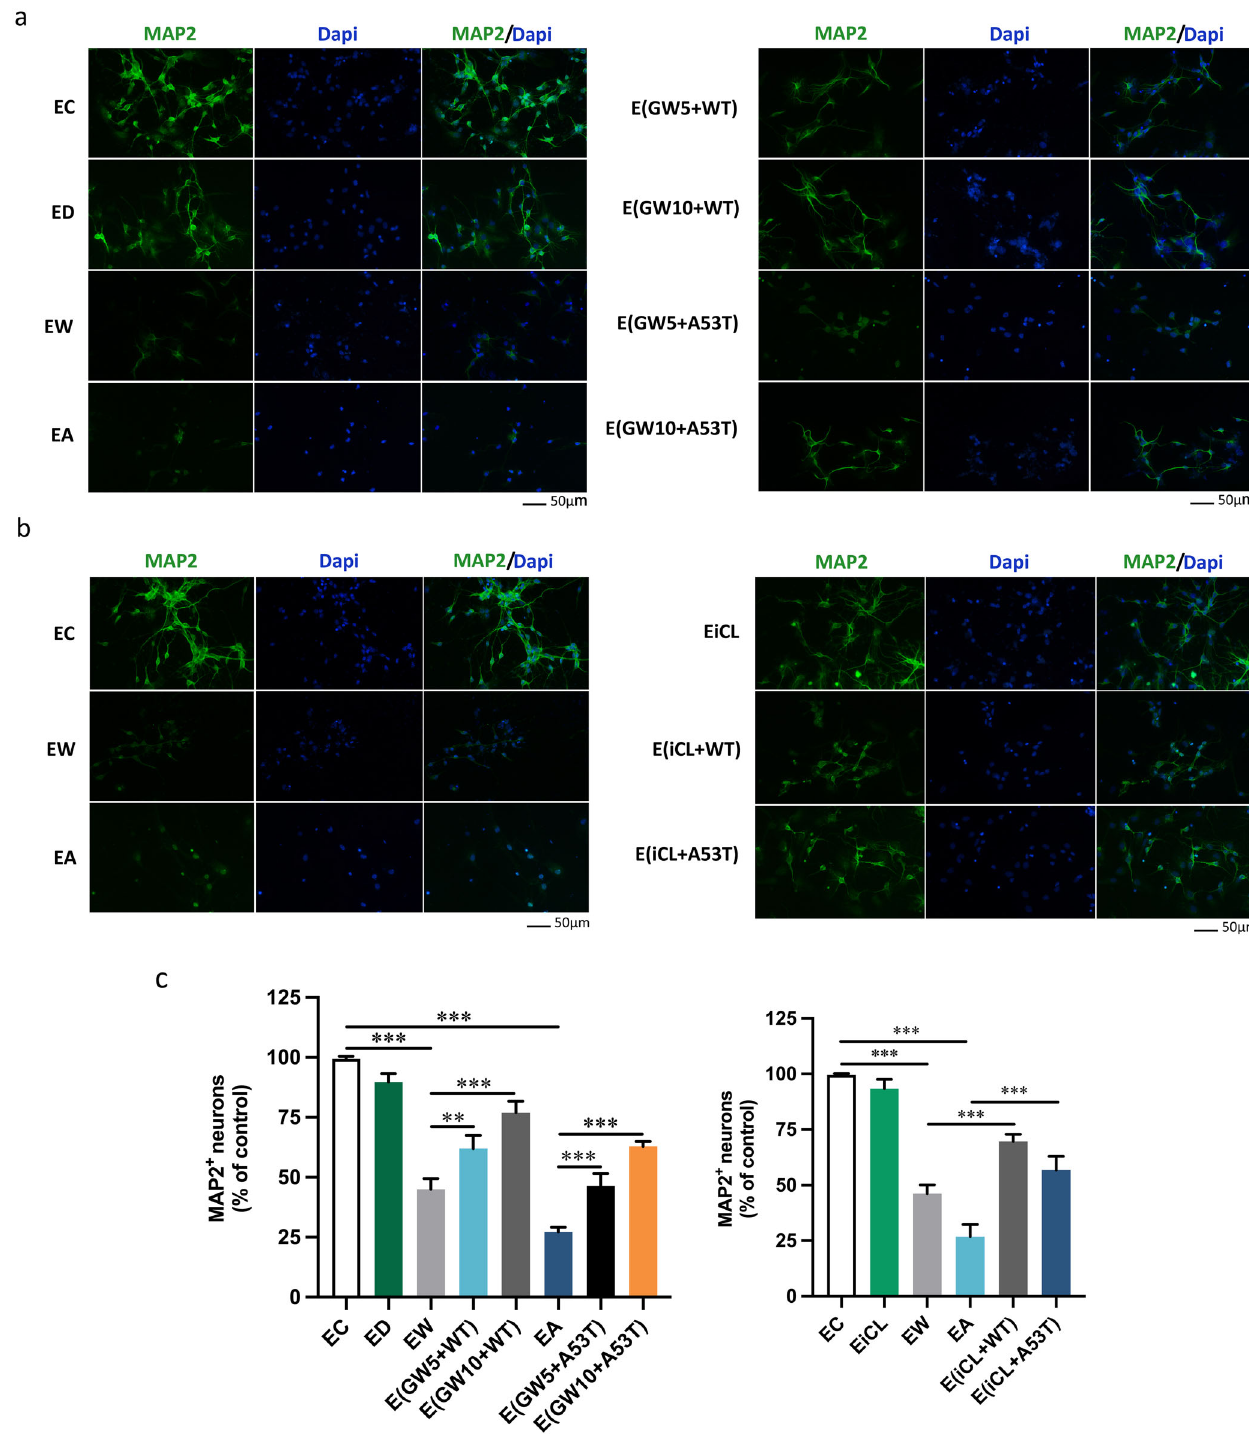
Fig. 6 Representative immuno fl uorescence images of neurons labelled with MAP2 illustrating the neurotoxic potential of CTSL- containing exosomes. a , b Treatment with GW4869 or the CTSL inhibitor iCL (20 μ M) prior to exosome isolation rescued CTSL-containing exosome-induced neurotoxicity in a dose-dependent manner in each experimental group, as determined by MAP2 immunostaining, suggesting a direct neurotoxic role for CTSL released from α -Syn oligomers-treated microglia. Scale bar: 50 μ m. c Quanti fi cation of the percentage of MAP2 + neurons for the experiments depicted in panels a (up) and b (down). Results are representative of three fl uorescent images of each group from three independent experiments. The amount of exosomes used in each group was secreted by approximately 10 4 microglia cells. EC = exosomes from untreated microglia (the control group); EW = exosomes from WT α -Syn oligomer-treated microglia; EA = exosomes from A53T α -Syn oligomer-treated microglia; ED = exosomes from DMSO-treated microglia; EiCL = exosomes from iCL-treated microglia; GW5 = 5 μ M GW4869; GW10 = 10 μ M GW4869. Error bars represent